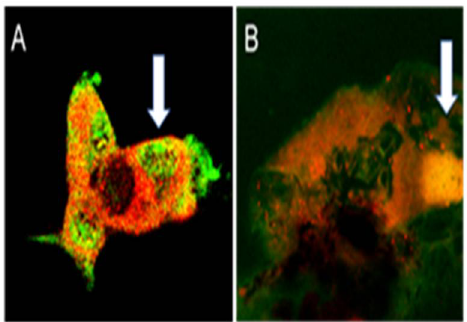
Figure 1. APNp1 binding to AdipoR1 . ( A ) AdipoR1 (red) and FITC-APNp1 (green) in primary CEC. ( B ) AdipoR1 (red) expression and FITC-APNp1 (green) within laser-induced CNV. The arrow indicates colocalization (yellow).